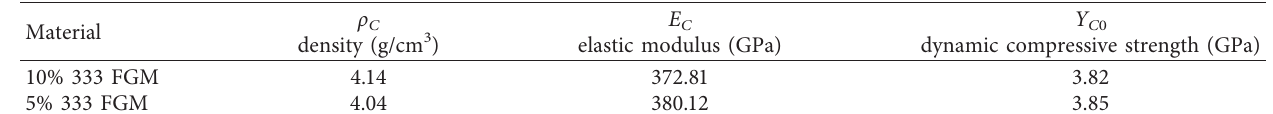
Table 6: Parameters of the trial plates using functionally graded ceramics.